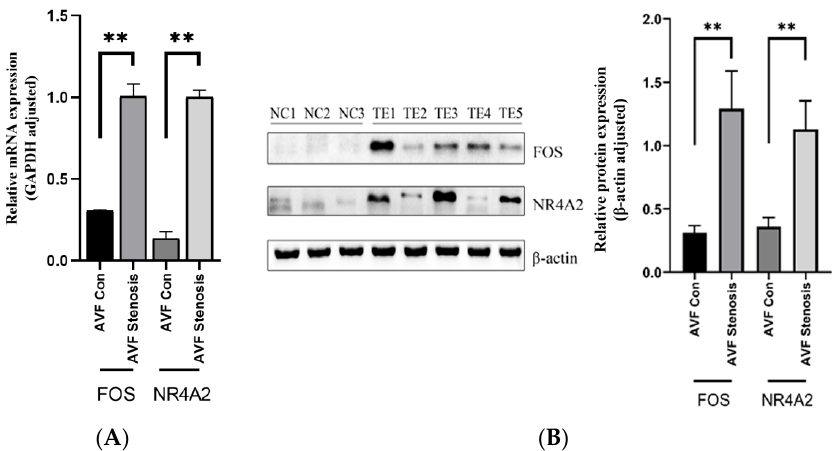
Figure 6. Expression levels of the mRNA and protein of FOS and NR4A2 : ( A ) mRNA expression level; ( B ) protein expression level. Data analysis was performed using the one-way ANOVA test. ** p < 0.01.